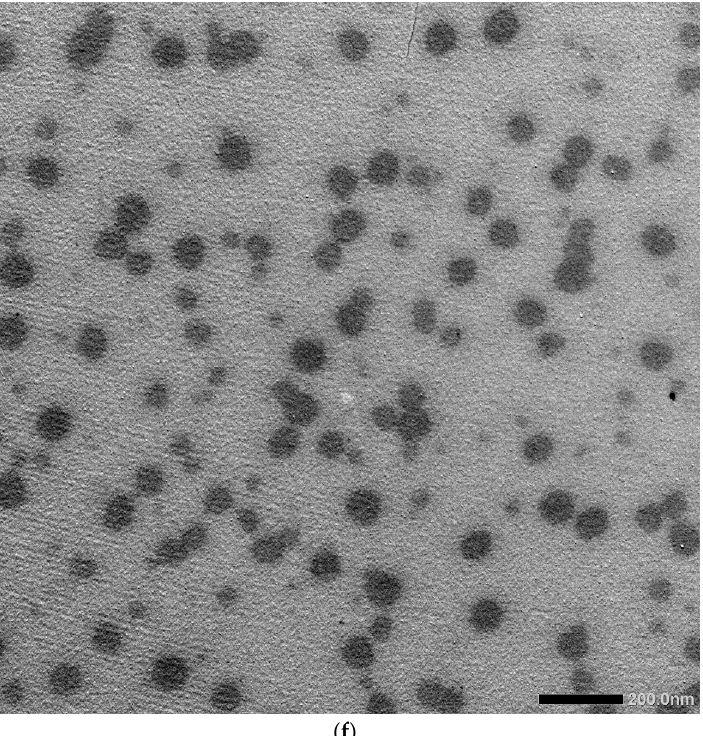
Figure 8. Mo-capped AgNPs characterization using X-ray diffraction ( a ), UV–vis ( b ), Fourier-transform infrared spectroscopy ( c ), scanning electron microscopy (×15,000) ( d ), energy-dispersive X-ray ( e ), and transmission electron microscope ( f ) analyses.